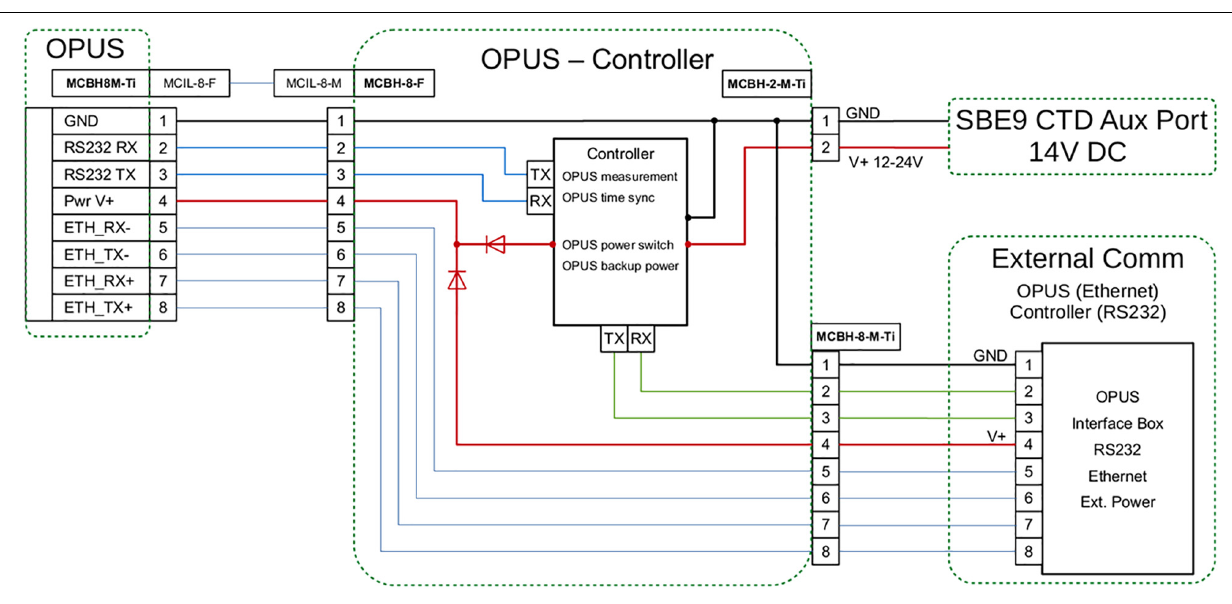
FIGURE 2 | Schematic of the wiring diagram of the controller for enhancing measurement frequency of OPUS